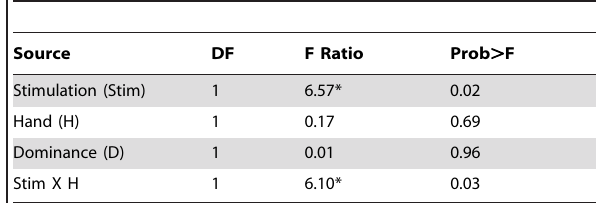
Table 5. Analysis of Variance for the accuracy of the average hand estimation.